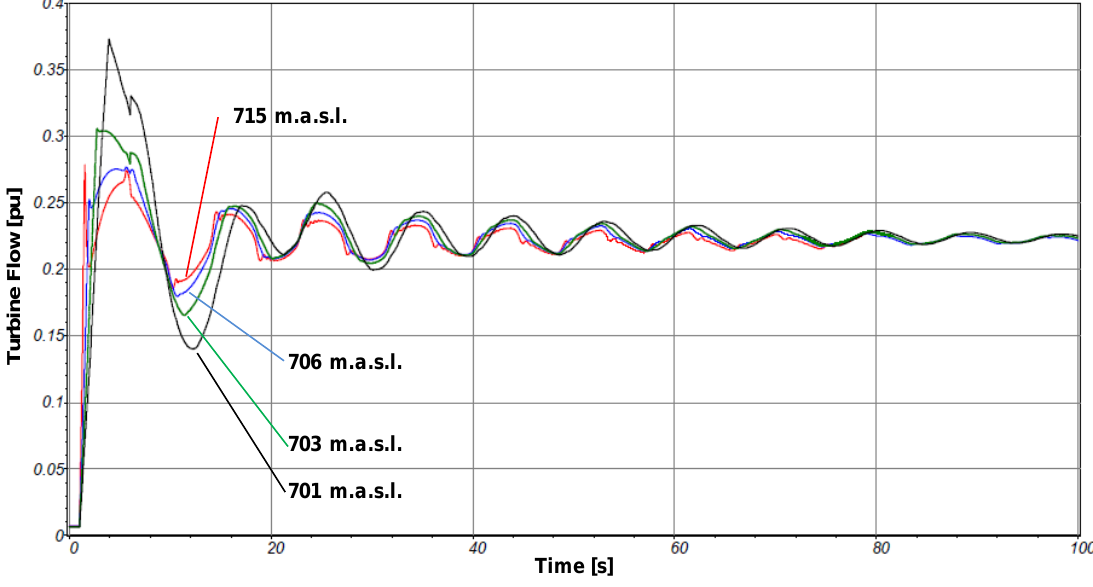
Figure 9. Turbine water flow after a wind generator trip for different upper reservoir levels (100 s) after a 2.3 MW wind generator trip.